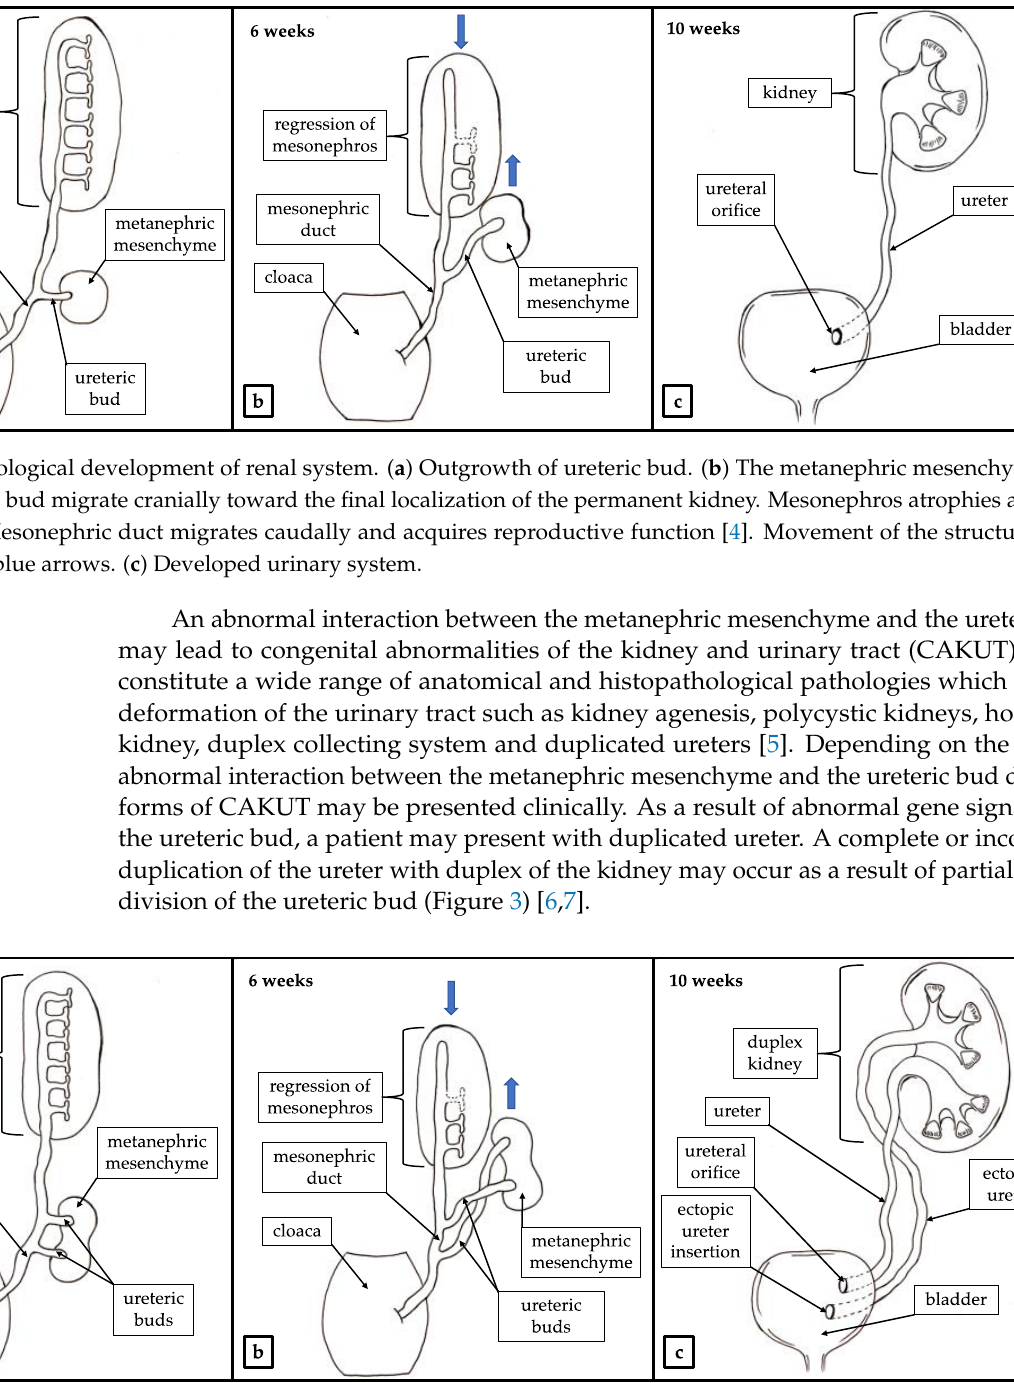
Figure 3. Development of the duplex kidney. ( a ) Outgrowth of two ureteric buds. ( b ) The metanephric mesenchyme and tureteric buds migrate cranially toward the final localization of the permanent kidney in accordance with Weigert—Mayer law. Mesonephros atrophies and degenerates. Mesonephric duct migrates caudally and acquires reproductive function [4]. Movement of the structures indicated with blue arrows. ( c ) Developed duplex kidney with ureteral ectopia.